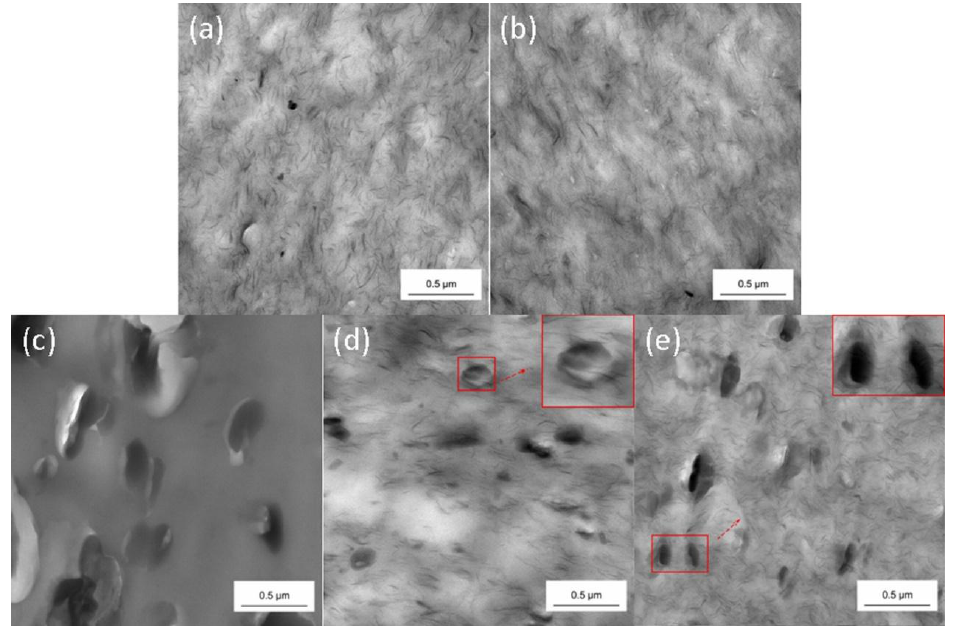
Figure 2. TEM images of ( a ) PA6/CMMT; ( b ) PA6/PMMT; ( c ) PA6/ABPA; ( d ) PA6/ABPA/CMMT; ( e ) PA6/ABPA/PMMT, in which the dark lines represent the clay platelets and the gray areas present the flame retardant particles.